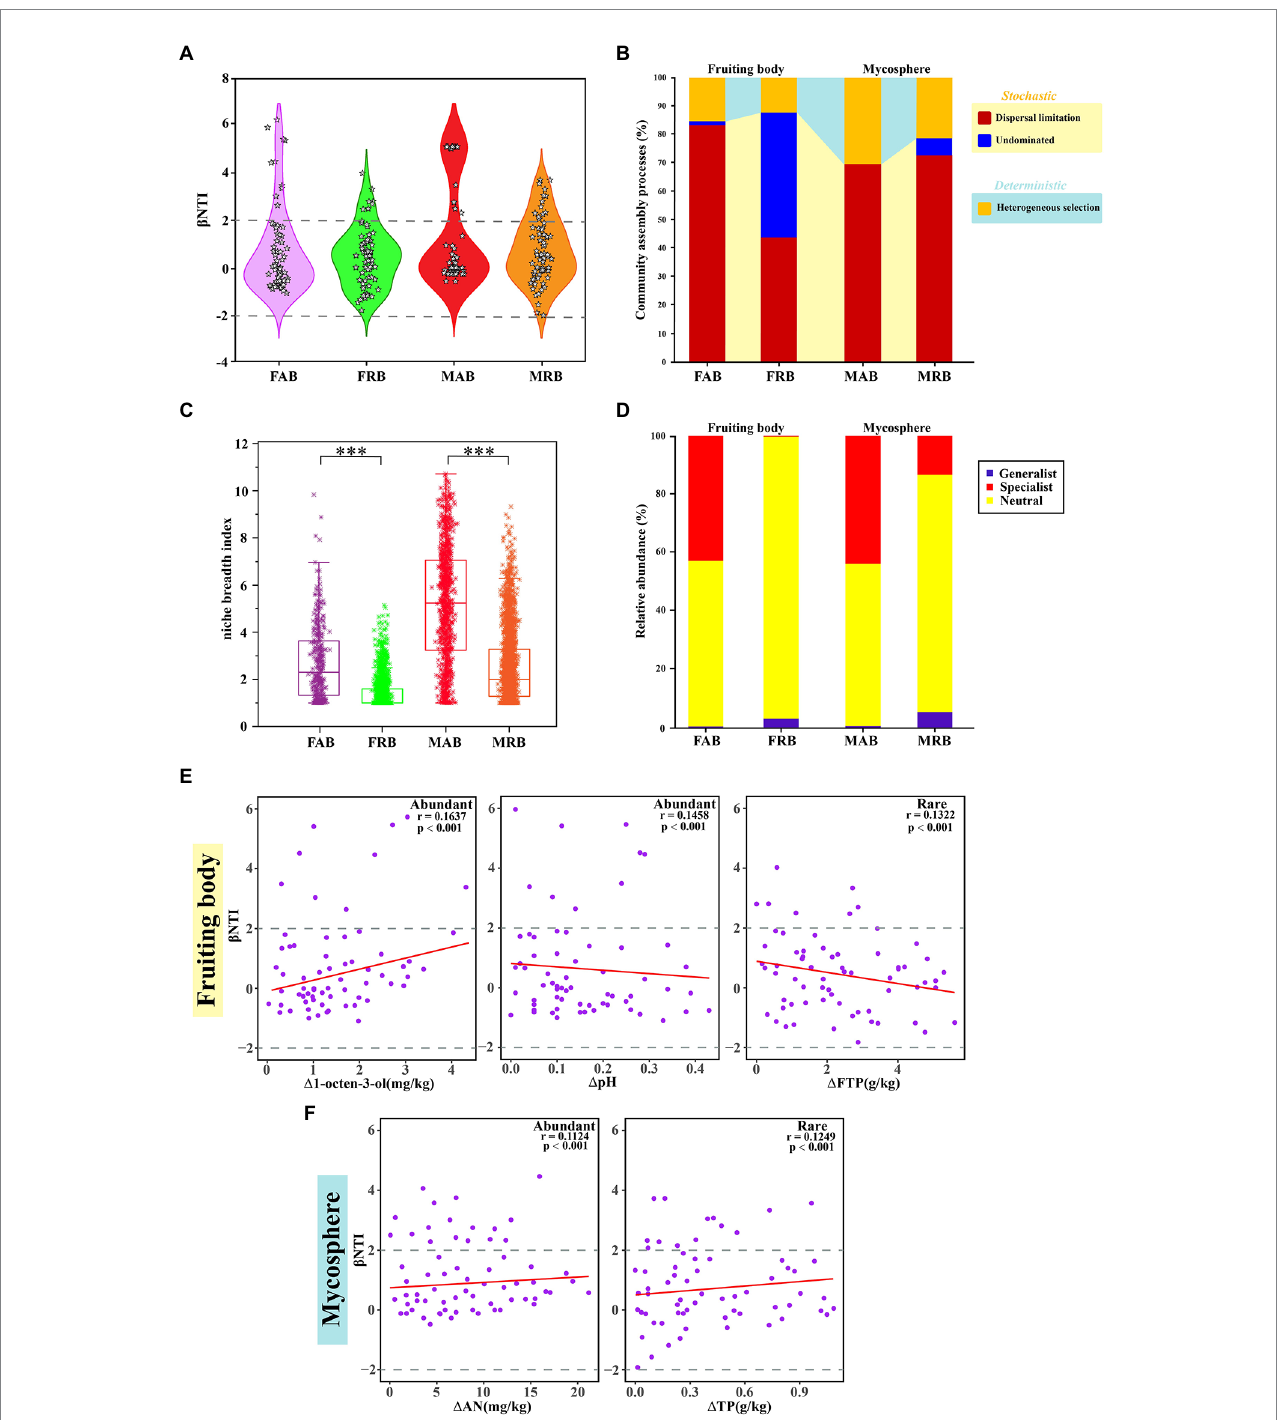
FIGURE 5 Null models and niche breadth index of the abundant and rare bacteria. (A) β NTI patterns of abundant and rare bacteria in the fruiting body and mycosphere. (B) The proportion of community assembly of the abundant and rare bacteria in the fruiting bodies and mycosphere is dominated by stochastic (dispersal limited and non-dominated) and partially deterministic (homogenous selection) processes. (C) Niche breadth of abundant and rare bacteria in fruitbody and mycosphere, these results were obtained based on the average of 100 bootstraps, and comparative analysis of abundant and rare bacteria within the sample was carried out using a t -test. * represent p < 0.05, ** represent 0.001 < p < 0.01, *** represent p < 0.001. (D) Relative abundance of the specialist, generalist, and neutral groups of abundant and rare bacteria in the fruiting bodies and mycosphere. (E) Spearman’s correlations between β -nearest taxon index ( β NTI) of communities in the fruiting body and changes in environmental variables. (F) Spearman’s correlations between β -nearest taxon index ( β NTI) of communities in the mycosphere soil and changes in environmental variables. FAB, abundant bacteria of the fruiting body; FRB, rare bacteria of the fruiting body; MAB, abundant bacteria of the mycosphere; MRB, rare bacteria of the mycosphere; FTP, total phosphorus of the fruiting body; AN, soil available nitrogen; TP, soil total